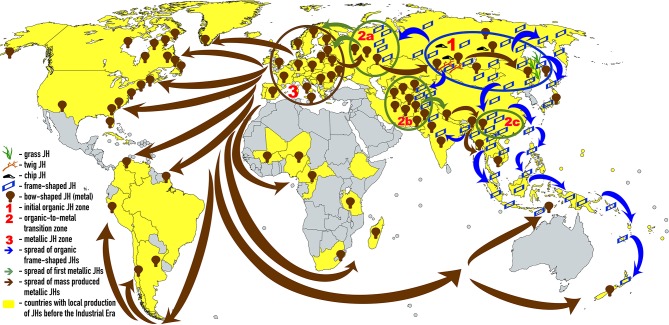
World distribution of JH made of organic and metallic materials prior to the Industrial Period. This map combines archaeological and ethnographic data on local production and consumption of JH across the world, excluding mass international trade from Europe, in order to establish the routes of the spread of metallic and non-metallic JH indigenous traditions. Yellow color marks those countries where JHs were produced and widely consumed by local population. Such countries were selected based on the integration of findings of linguistic research on the presence of native words for JH in local languages (Fox, 1994; Sheikin, 2002, p. 411–503; Bakx and Crane, 2017), of archaeological finds (de Ramón and Rivera, 1982; Beck et al., 1983; Barr, 1994; Kungurov, 1994; Yakovlev, 2001; Pignocchi, 2002, 2004; Crane, 2007; Wright and Impey, 2007; Wright, 2011; Honeychurch, 2015, p. 20; Whitridge, 2015) [plus references from Table 1], and of geo-ethnographic research (Vertkov et al., 1963; Galaiskaya, 1973; Fox, 1988, 1994; Sheikin, 2002; Wright, 2004; Yesipova et al., 2008; Suzukei, 2010; Mamcheva, 2012). Geo-ethnographic data was also used to distinguish between the areas of distribution of bow-shaped metallic and frame-shaped organic JHs. Five icons with corresponding pictures mark the geographic locations of musical cultures that use JHs made of different materials. Red numbers indicate the zones of distribution for different types of JHs—encircled in different colors. (Number 1) Marks the blue oval that shows the area where organic-made JHs have been prevalent (see Figure 4). This area most likely constitutes the cradle of JH music. (Number 2) Marks the green ovals that encircle the areas where metallic JHs have coexisted with organic ones. It is in these areas, that presumably, the transition from organic to metallic instruments took place. Two areas [(2a) and (2b)] correspond to the oldest centers of metallurgy (see Figure 8). The transition probably occurred first in 2a), where the access for import of organic JHs from zone (1) was geographically broader and easier than in (2b), and organic JHs were likely to have been established prior to the wide spread of metallic artifacts. Transition in (2c) area most likely occurred much later because of the later arrival of metallurgy (see Figure 8). (Number 3) Marks the brown oval that encircles the area where exclusively metallic JHs were cultivated. The color-coded arrows show the probable direction for spreading of the organic and metallic JH technologies. Green arrows indicate the distribution of the initial handicraft metallic JHs that might have emulated popular wooden/bone/bamboo types. Brown arrows indicate the distribution of the mass-produced bow-shaped metallic construction, prevalent in Europe. Across the ocean, these arrows connect the European dominions with their offshore colonies. Over the land, brown arrows indicate the chain of cultural contacts that led to the establishment of local production centers of metallic JHs. Evidently, one of the routes of this spread went contrary to the original spread of the organic JHs—from European West to Far East, over the Steppe Belt's borderline with the northern forests via the chain of neighboring Turkic cultures that all favor metallic JHs. This route earned the nickname of “Fur Route” (Rubinson, 1992; Bunker, 1993). Another route went from Central Asia to China via the Silk Road—historic as well as prehistoric, as recent research suggested (Christian, 2000; Kuzmina, 2008; Barinova, 2013).